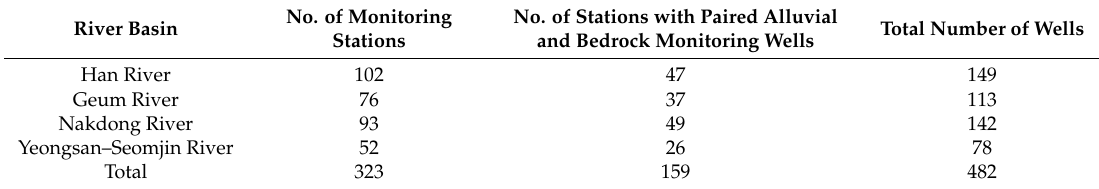
Table 1. National Groundwater Monitoring Stations in major river basins in Korea in